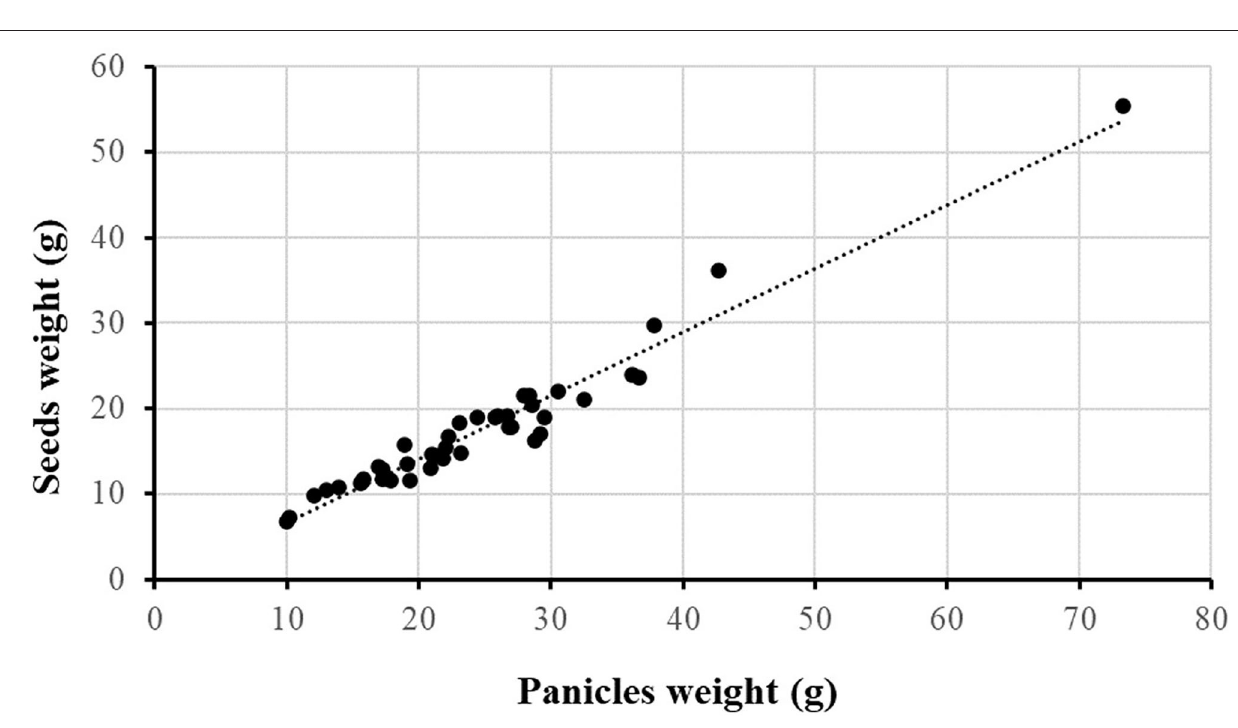
populations, whereas biomass allocated to rhizomes was similar ( Figure 5